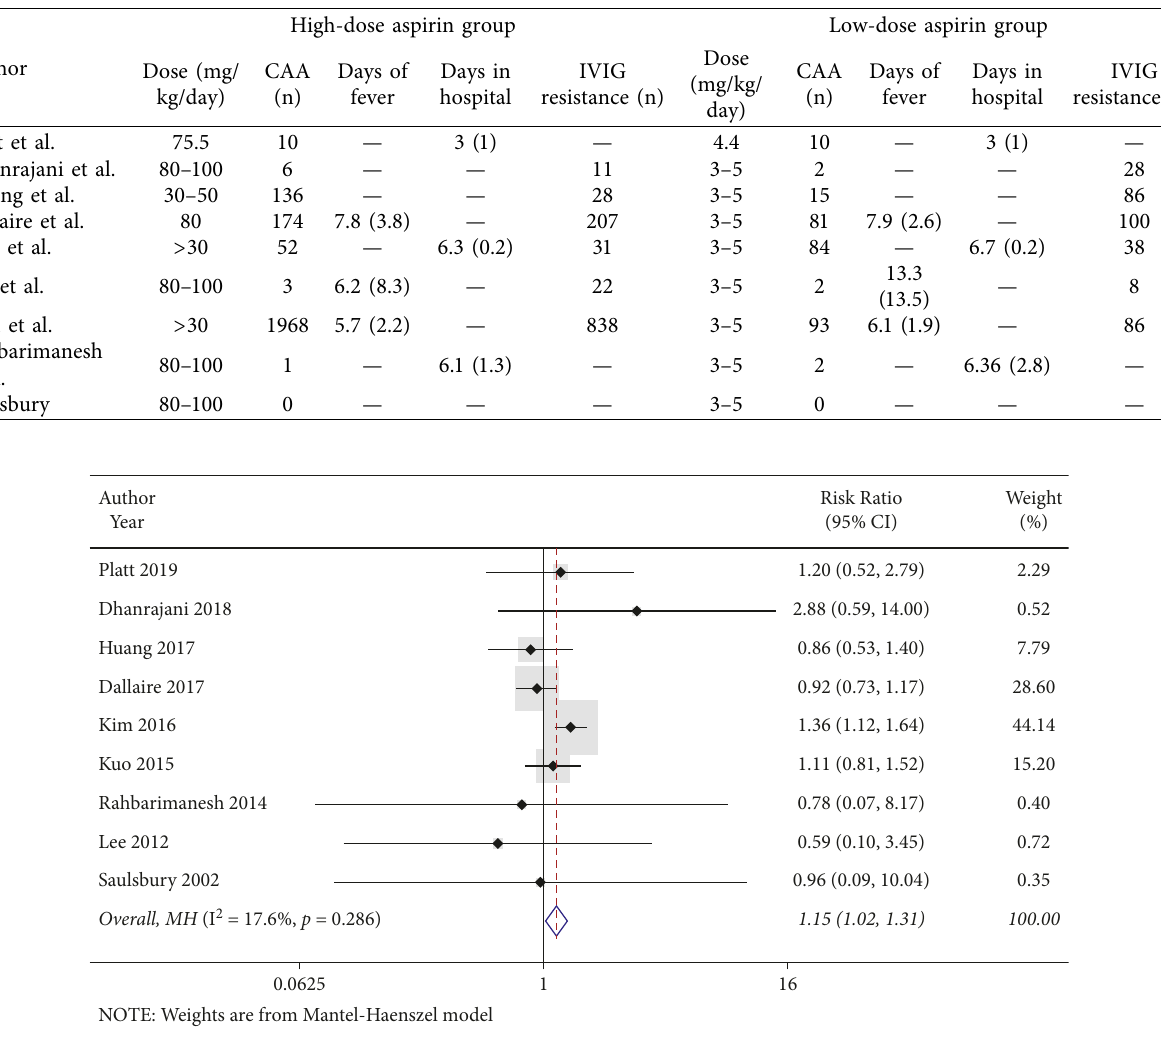
Figure 2: The relative risk of coronary artery abnormalities identified in the meta-analysis from nine enrolled